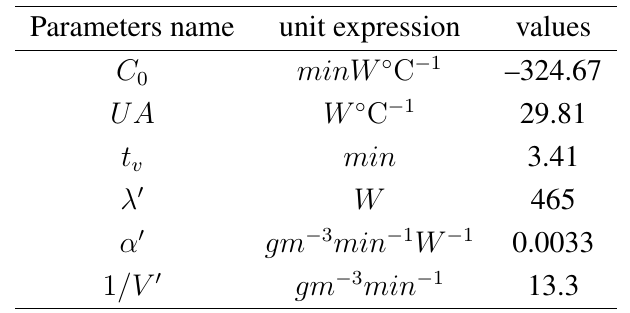
Table 1. Identified greenhouse model